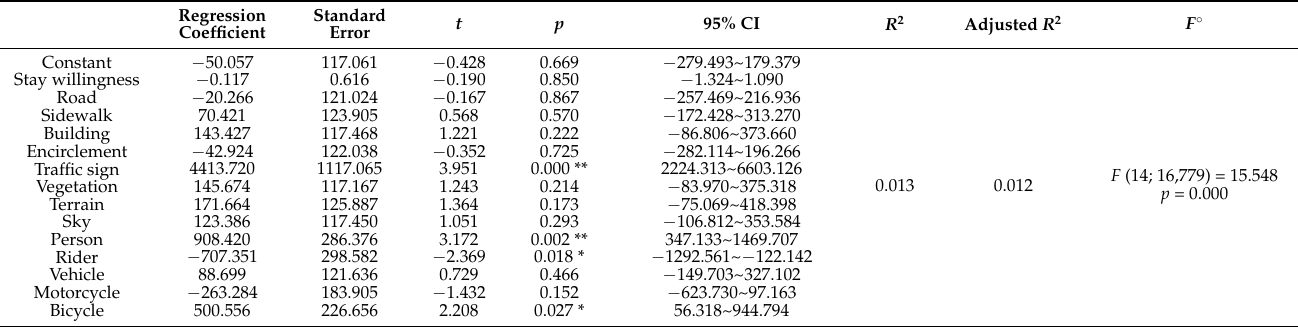
Table 9. OLS analysis with consumption per capita as the dependent variable ( n =